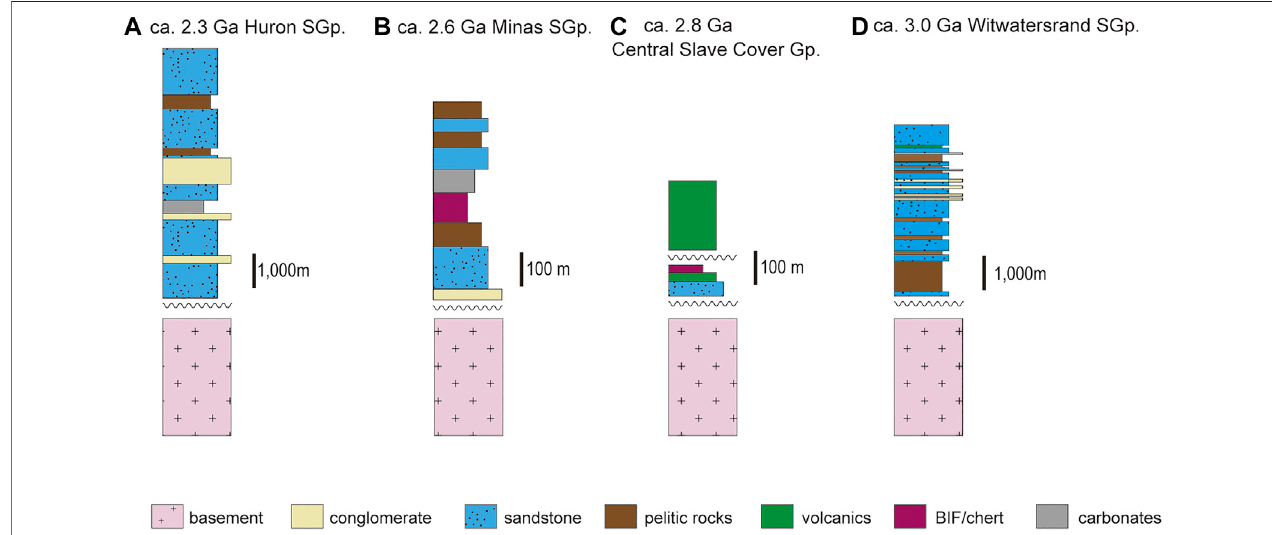
FIGURE 3 | Stratigraphic columns of representative quartzose sandstone layer from ca. 3.0 Ga to ca. 2.3 Ga. (A) ca. 2.3 Ga Huron Supergroup on the Superior Craton (Roscoe and Card, 1993). (B) ca. 2.6 Ga Minas Supergroup in the Sao Francisco Craton (Minter et al., 1990; Koglin et al., 2014); (C) ca. 2.8 Ga Central Slave Cover Group in the Slave Craton (Bleeker et al., 1999); (D) ca. 3.0 Ga West Rand Group of the Witwatersrand Supergroup in the Kaapvaal Craton (Frimmel, 2010).